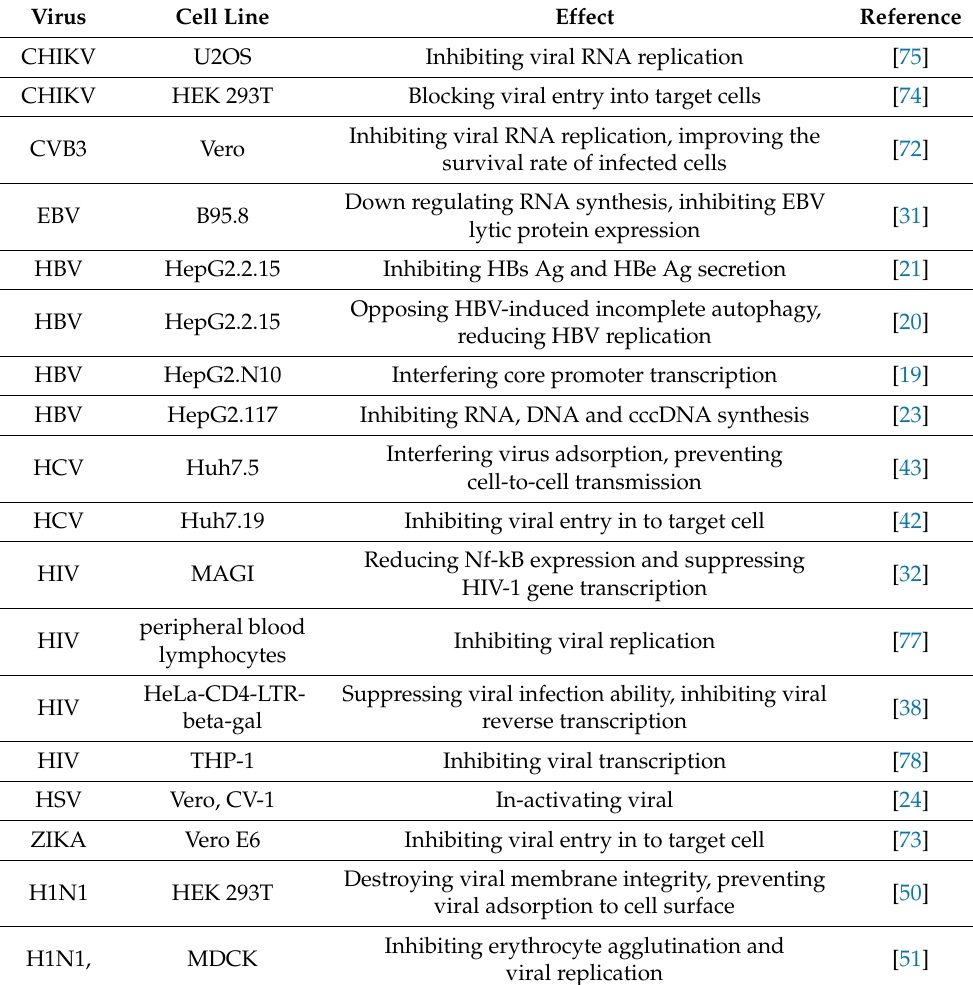
Table 2. Inhibitory effects of EGCG against